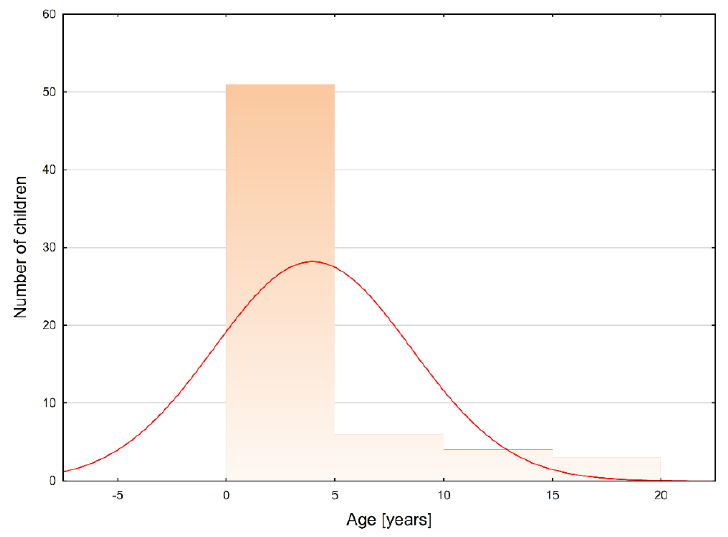
Figure 3. The age distribution among pediatric patients who developed intramedullary spinal cord abscesses (Shapiro − Wilk test: p < 0.001). Legend: red curve − expected normal distribution.